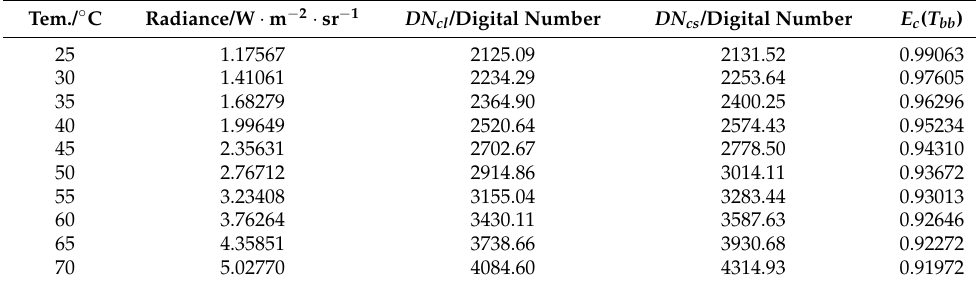
Table 3. Experimental data and calculation of E c ( T bb ) .